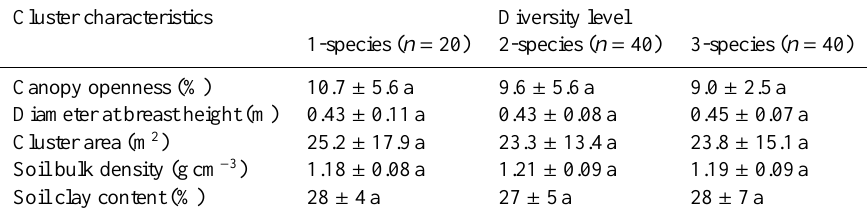
Figure 1. Location of the 100 tree clusters in the two forest areas. The grey dots and black rectangles indicate cluster positions. The 16 black rectangles represent intensively measured clusters (figure based on Seidel, 2011). Table 1. Soil properties (0–0.3m soil depth) and structural characteristics of the one- to three-species tree clusters (means ± sd). Similar letters indicate no significant di ff erences between the three diversity levels ( p ≤ 0 . 05, ANOVA and Tukey’s HSD or Kruskal–Wallis test, canopy